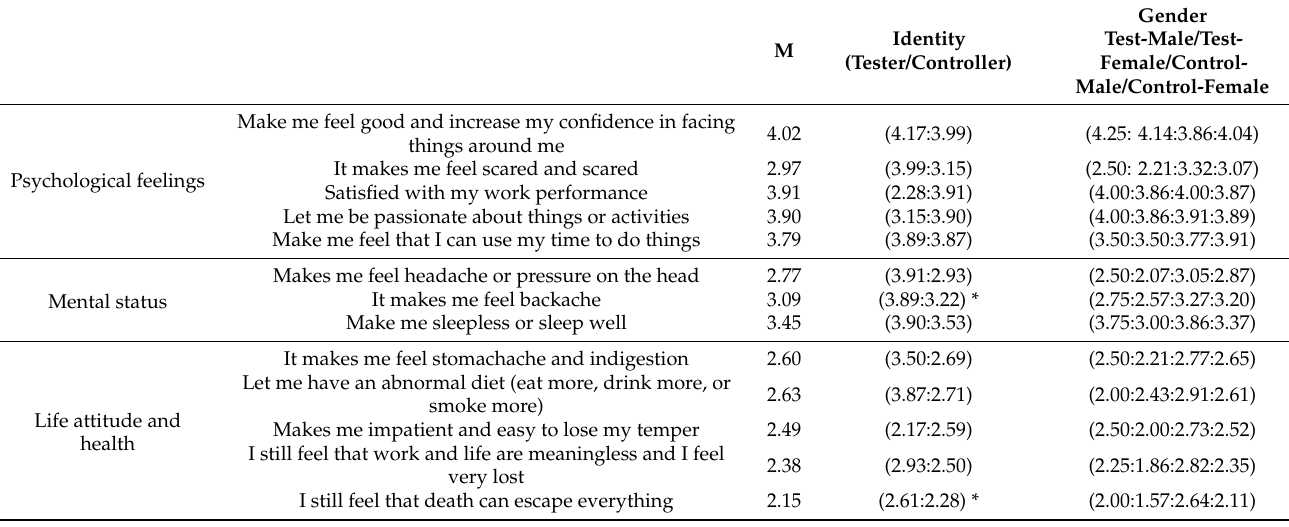
Table 8. Analysis of physical and mental health awareness of subjects with different experimental contents.